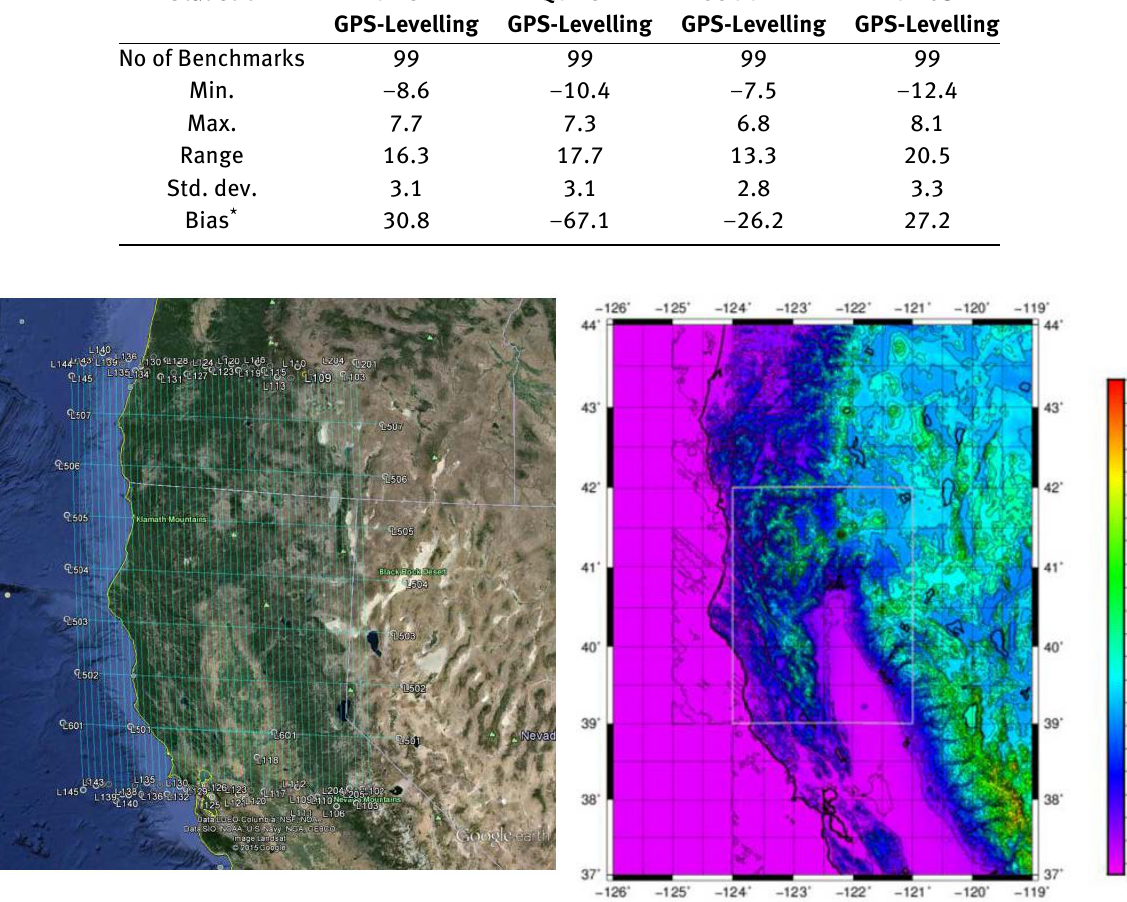
Figure 7: Data coverage of California test area plotted in Google Earth Figure 8: Topographical heights in the California test area from SRTM 30” data in 200 meter contours. The height range within the target geoid area is from 0 to 4070